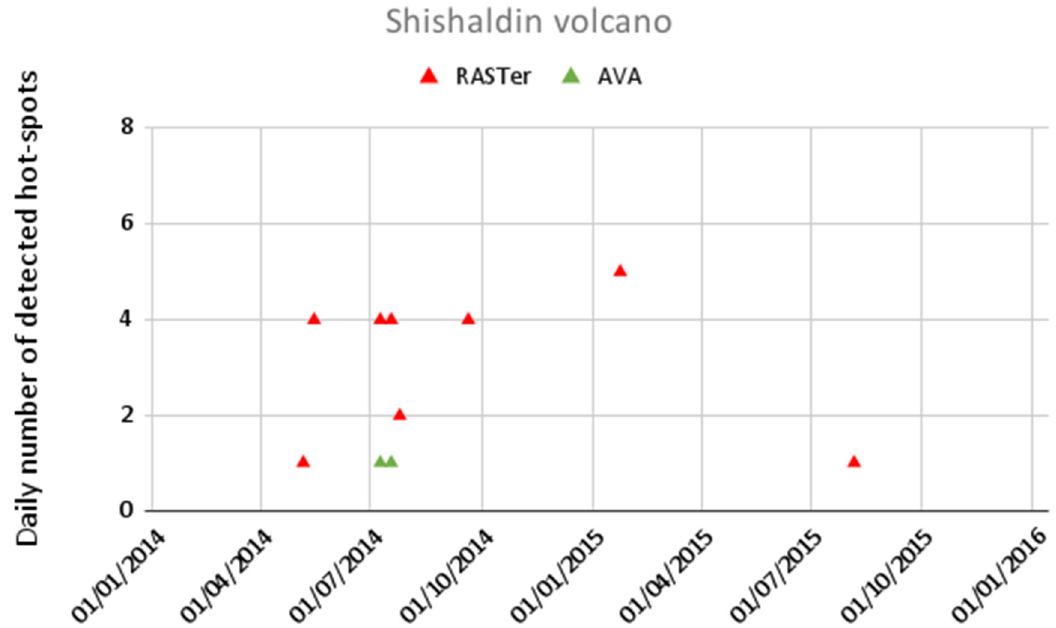
Figure 5. Time series of daily number of hotspots flagged by RASTer and AVA (January 2014–2016) at Shishaldin volcano. Additionally, to assess the RASTer capacity in providing information about thermal anomalies at Shishaldin in recent years, Figure 6a shows an example of thermal anomalies detected on ASTER TIR data on 20 October 2019, in correspondence with a minor thermal activity that occurred at the summit crater. Figure 6b displays the lava flow on 8 January 2020, separating in two branches moving in the NW and NE direction, respectively. Those